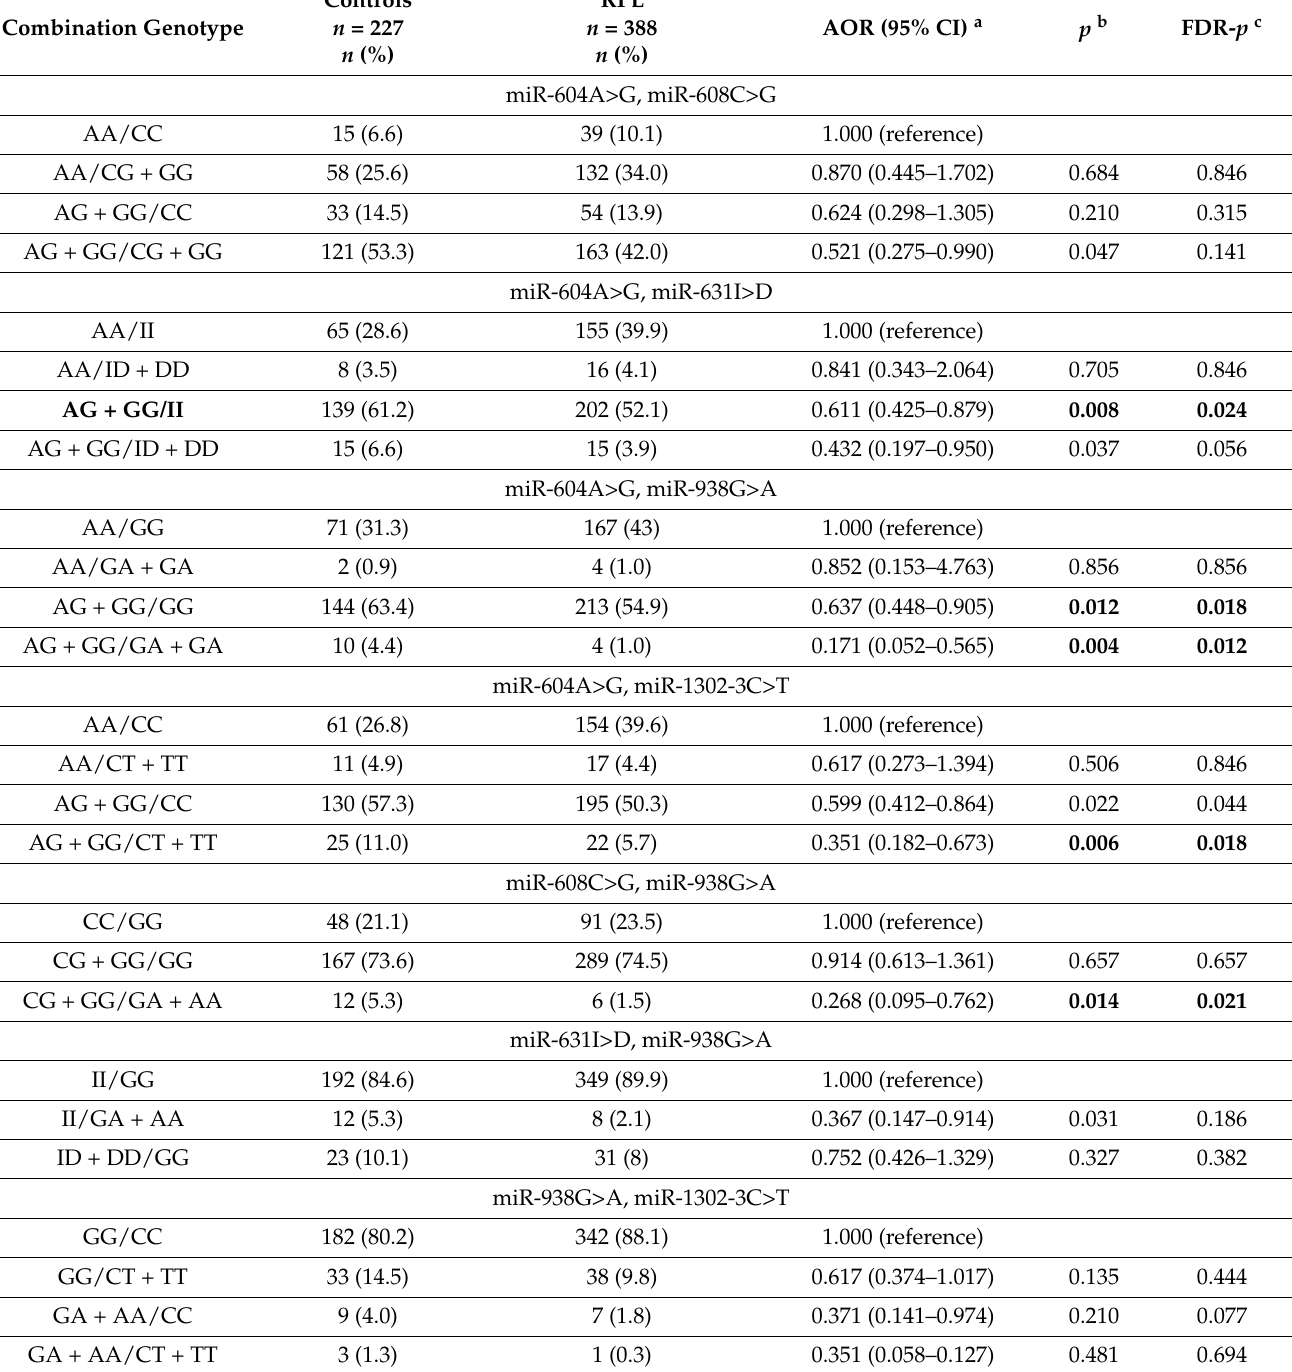
Table 4. Combined analysis of microRNA gene polymorphisms in RPL patients and